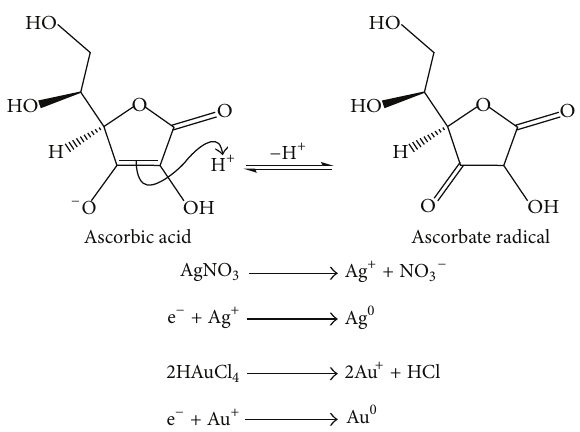
Figure 3: Ascorbic acid reduction of gold and silver ions to Au 0 and Ag 0 nanoparticles.